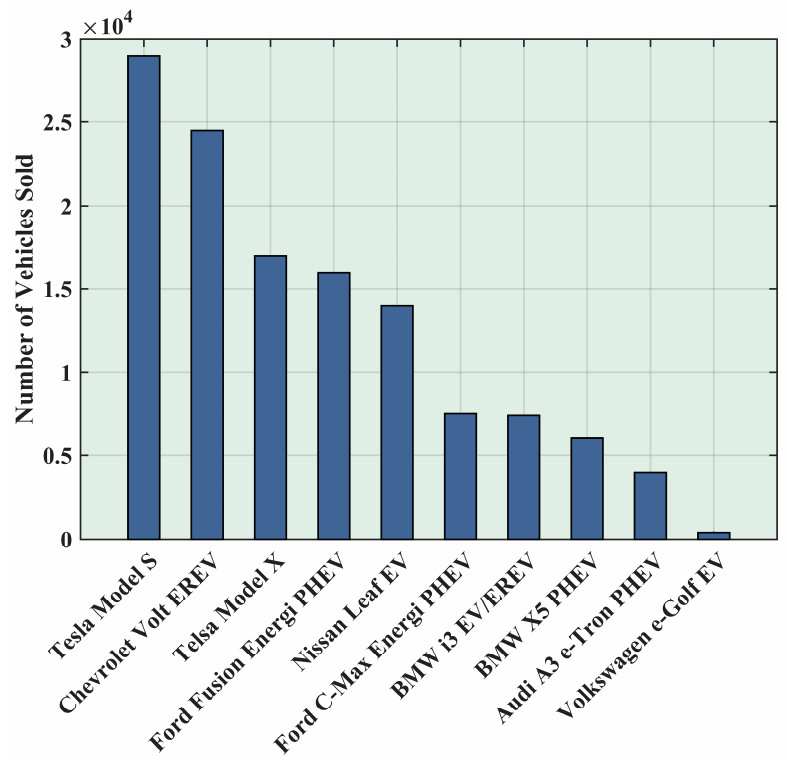
Figure 77. Top ten best-selling EVs in the USA in 2016. Data from [192].